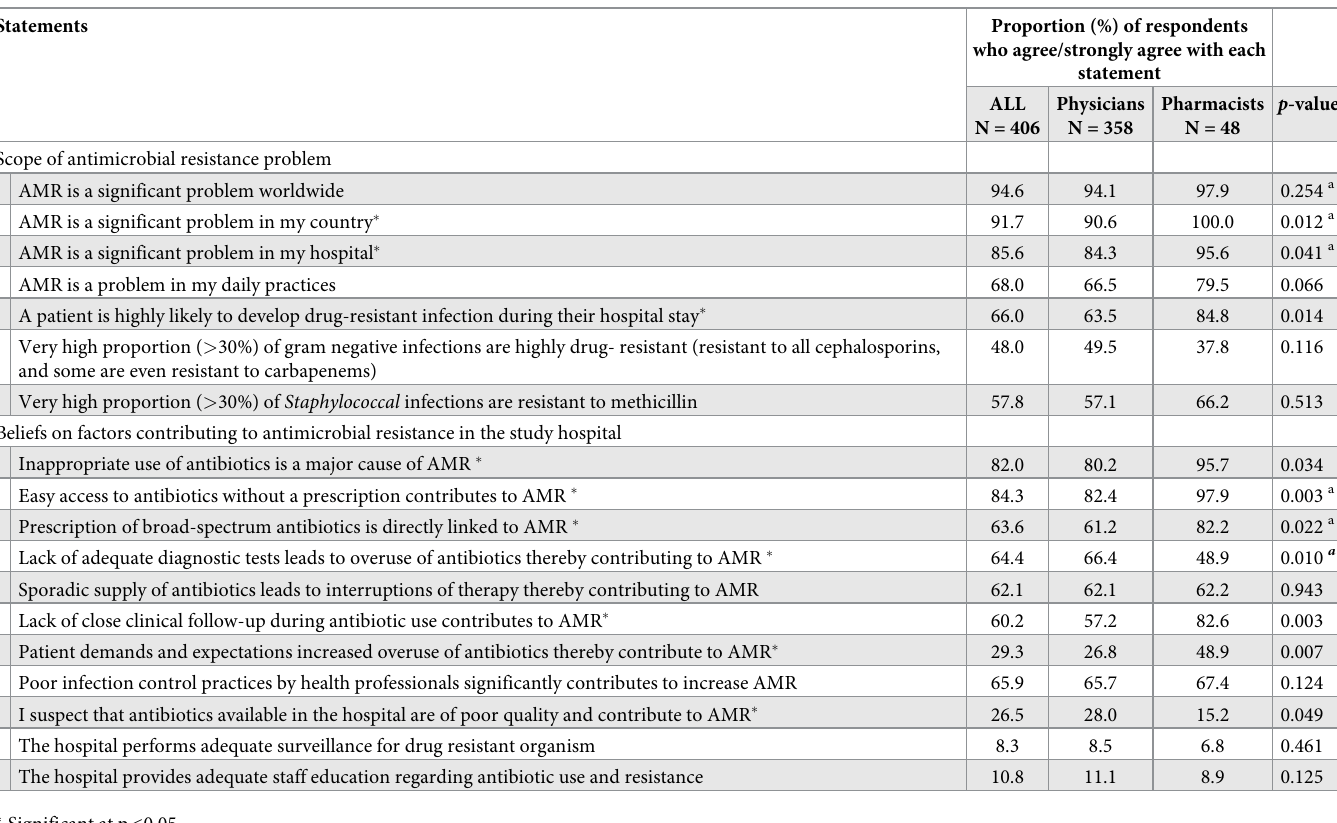
Table 2. Physicians’ and pharmacists’ perception on Antimicrobial Resistance (AMR) and contributing